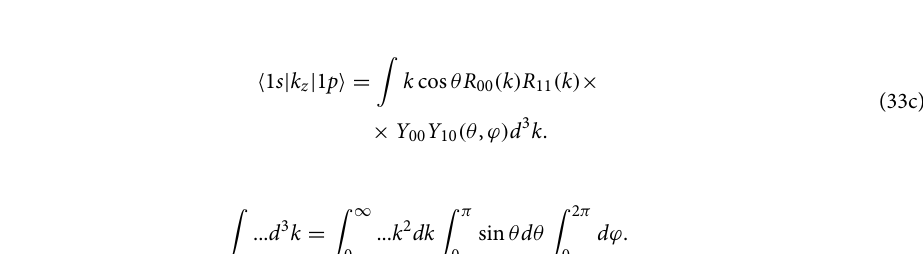
Figure 4. The components (shown near curves) of oscillator strength (dipole matrix element Eq. (32)) for transition between the states 1 s and 1 p as functions of Lévy index µ . Both functions are strongly decreasing as 0 µ →